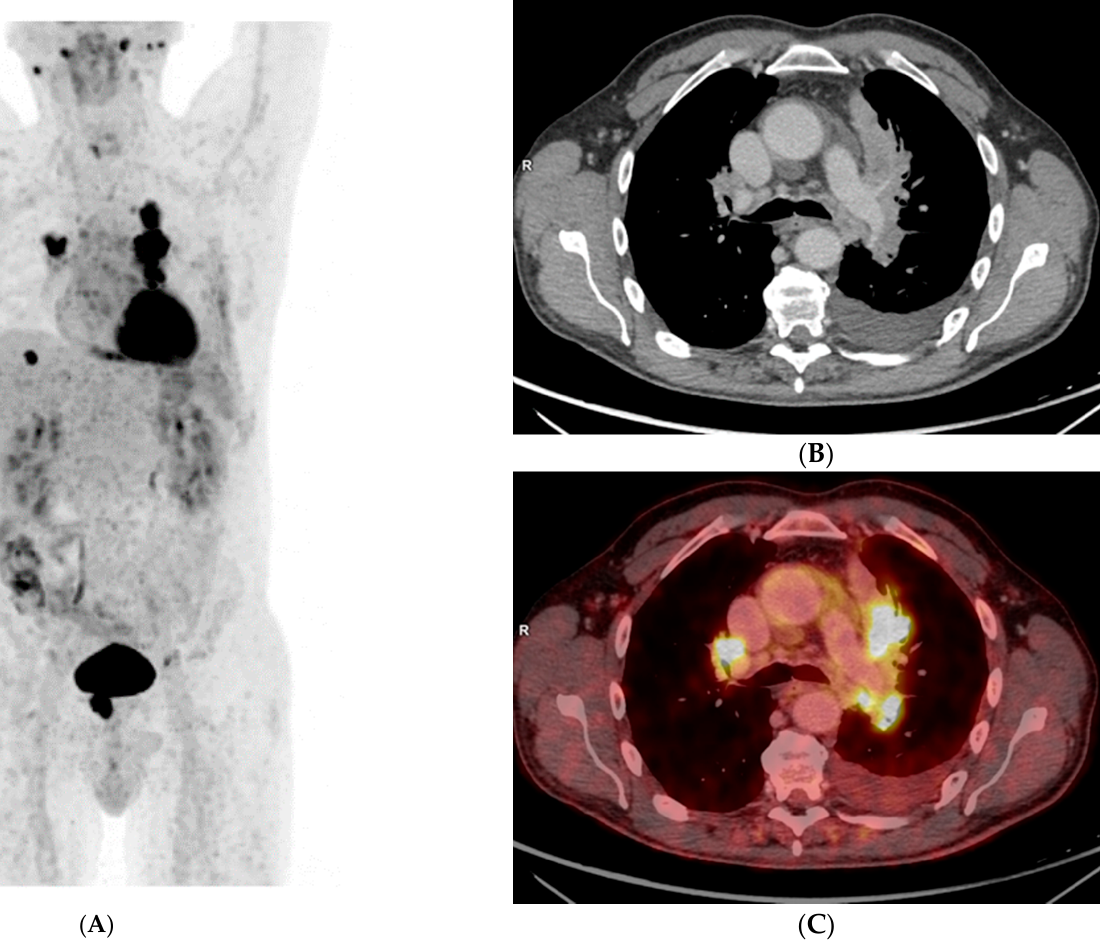
Figure 2. ( A ) Maximum Intensity Projection (MIP) FDG-PET showing multiple FDG-avid lesions, ( B ) transaxial CT image showing a tumor atelectasis complex in the left upper lung’s lobe and enlarged lymph nodes in both hila, ( C ) same as (B) fused with FDG-PET.